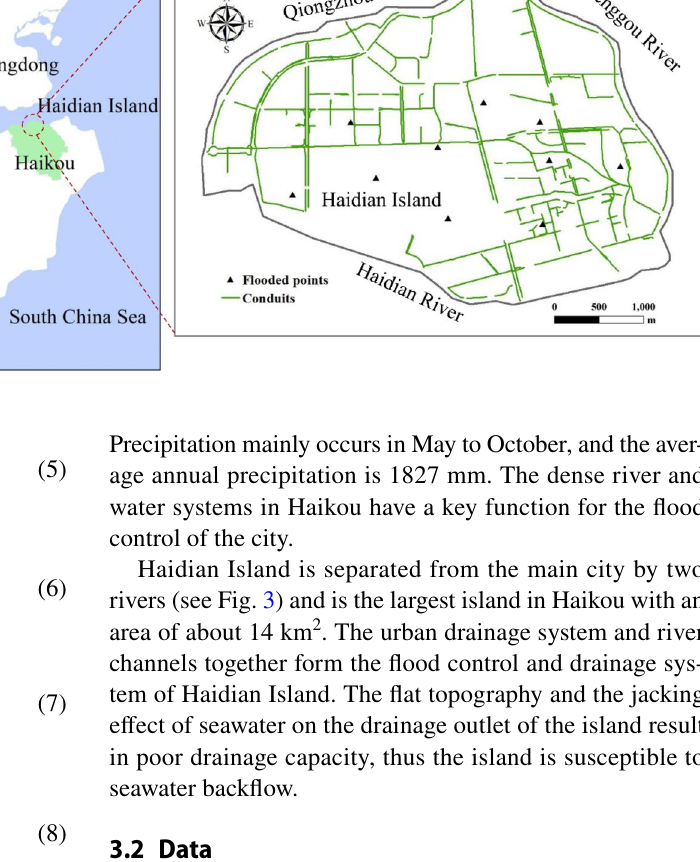
Fig. 3 The Haidian Island study area on Hainan Island, China, and the location of 10 flood- prone